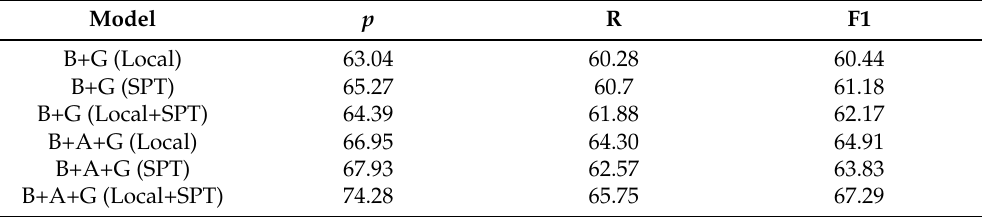
Table 3. Results of ablation experiments with different models (unit: %).